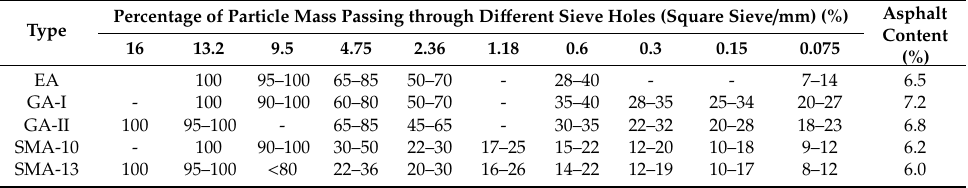
Table 1. Design of mixture proportions in the experiment.